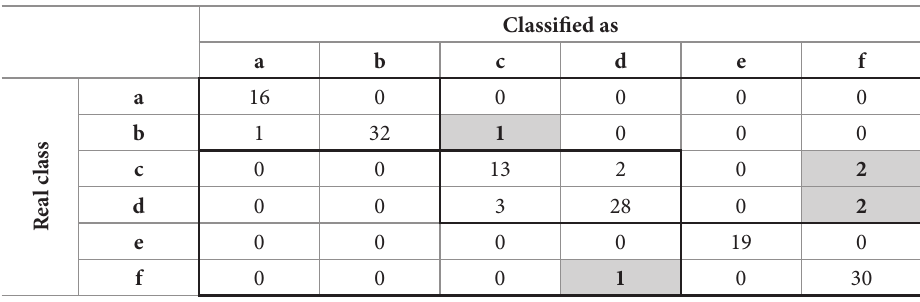
Table 3. Confusion matrix for decomposed classes